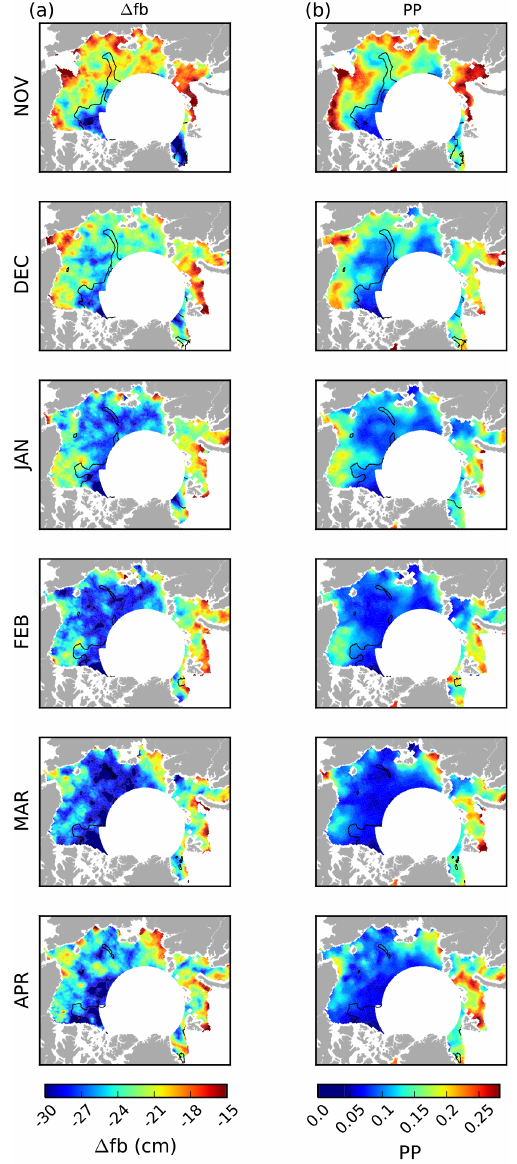
Figure 4. (a) Monthly freeboard difference ( (cid:49) fb) between Envisat and CryoSat-2 and (b) monthly Envisat pulse peakiness (PP) shown for the November 2010–April 2011 period. The dark lines represent the isoline MYI fraction equal to